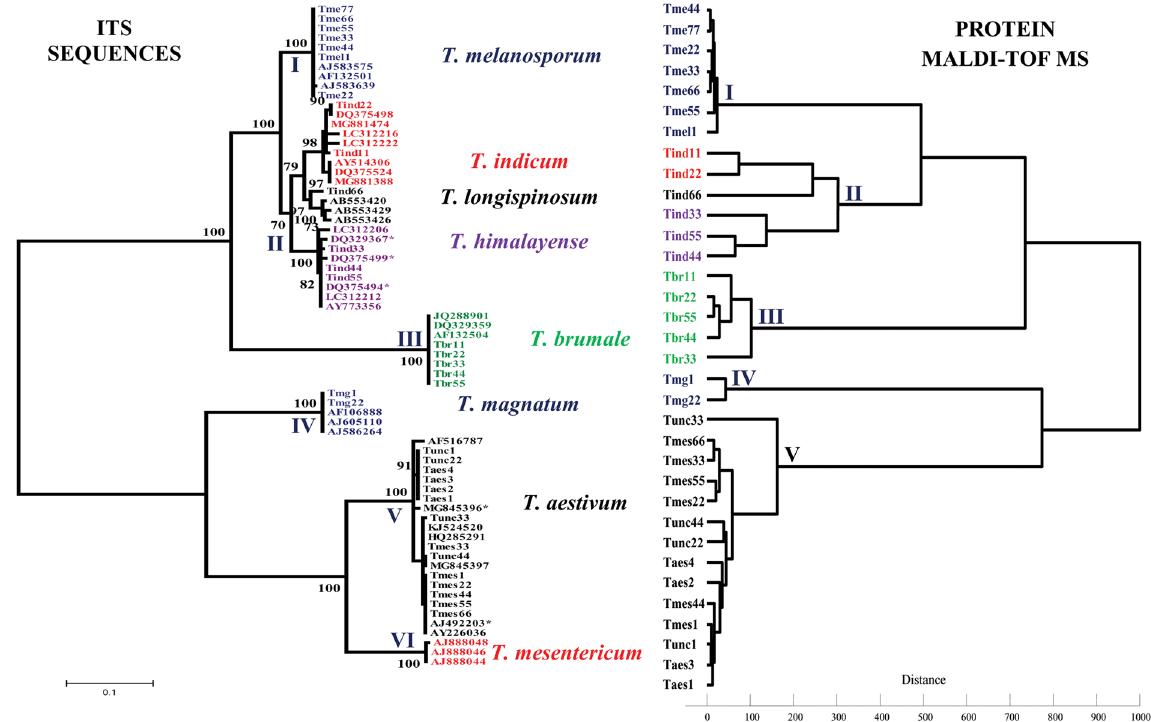
Figure 1. Phylogenetic tree and dendrogram inferred from ITS sequences and protein MALDI-TOF MS of Tuber species, respectively. The “ * ” symbol means that the specimens were misannotated as T . indicum or T . uncinatum in the GenBank